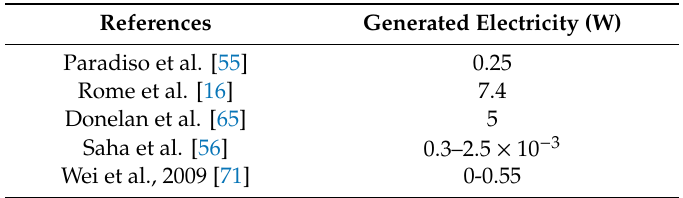
Table 2. Output power of several typical human motion driven